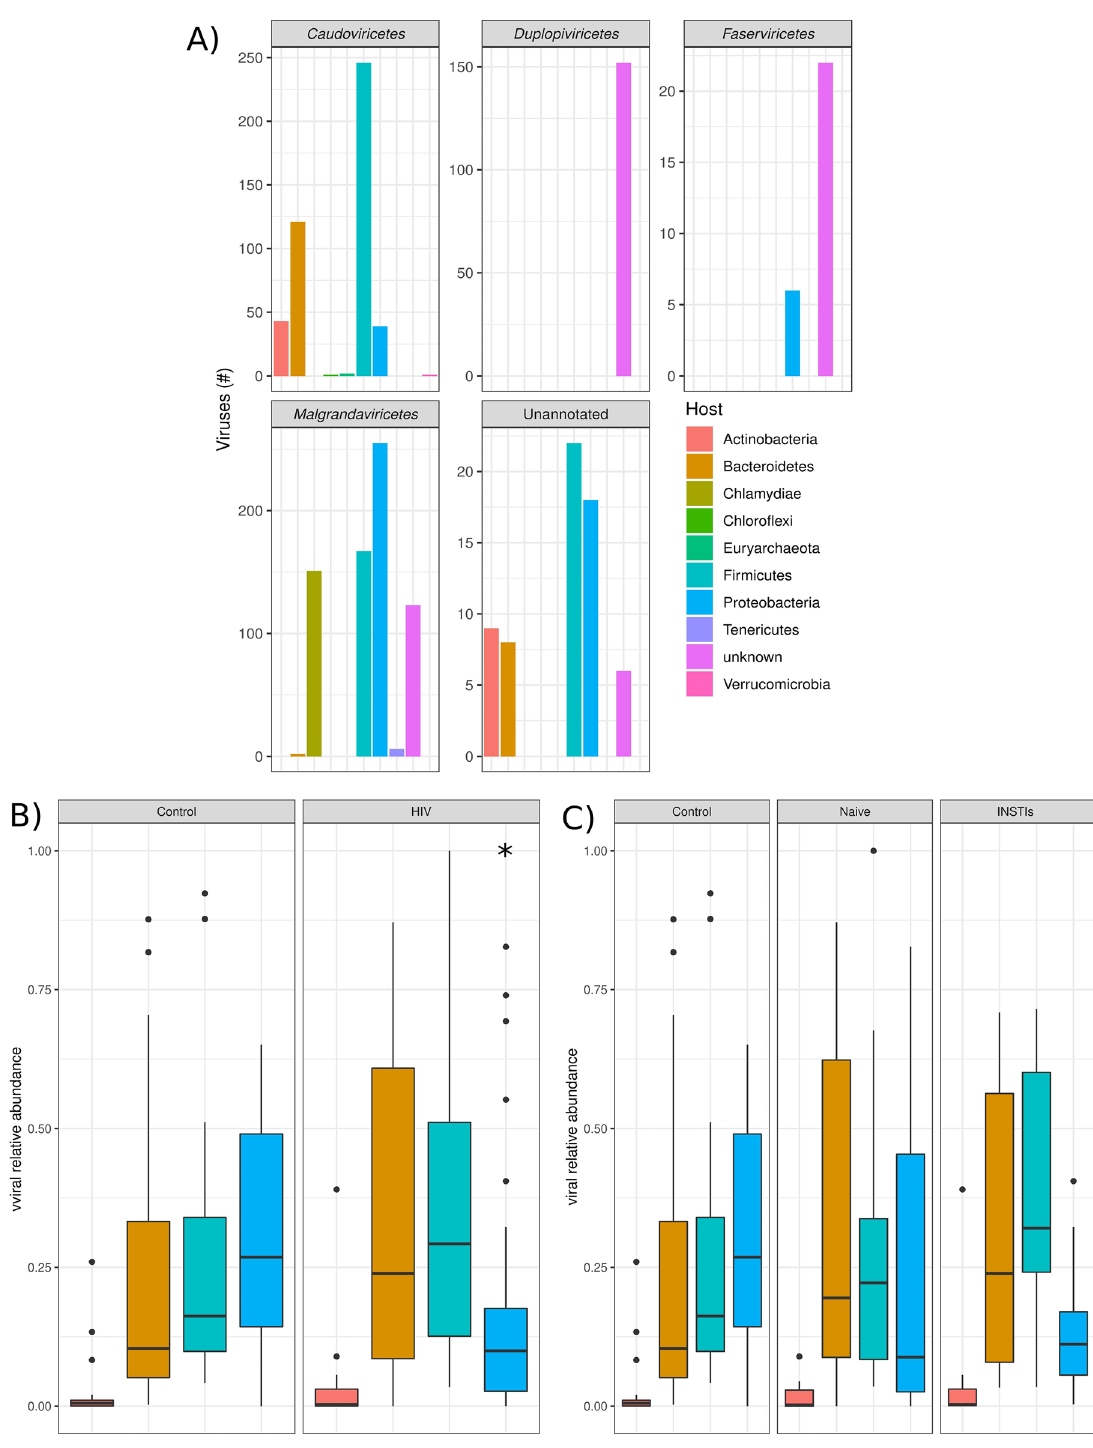
Figure 5. Host prediction of the phages belonging to different classes. ( A ) Prediction of which bacteria is infected by phage grouped based on class-level taxonomy. ( B ) Differences between control and HIV-infected patients in the relative abundance of the phages infecting bacterial phyla. ( C ) Differences between control, naive, and INSTIs in the relative abundance of the phages infecting bacterial phyla. *p < 0.05 vs. control. INSTIs (integrase strand transfer inhibitors-based